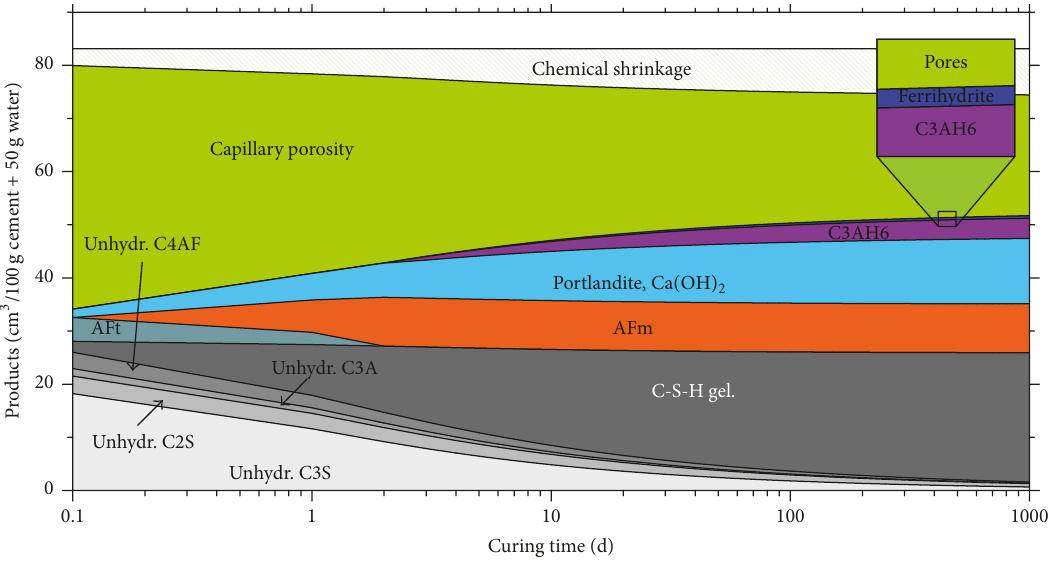
Figure 9: Hydrates evolution over curing time.